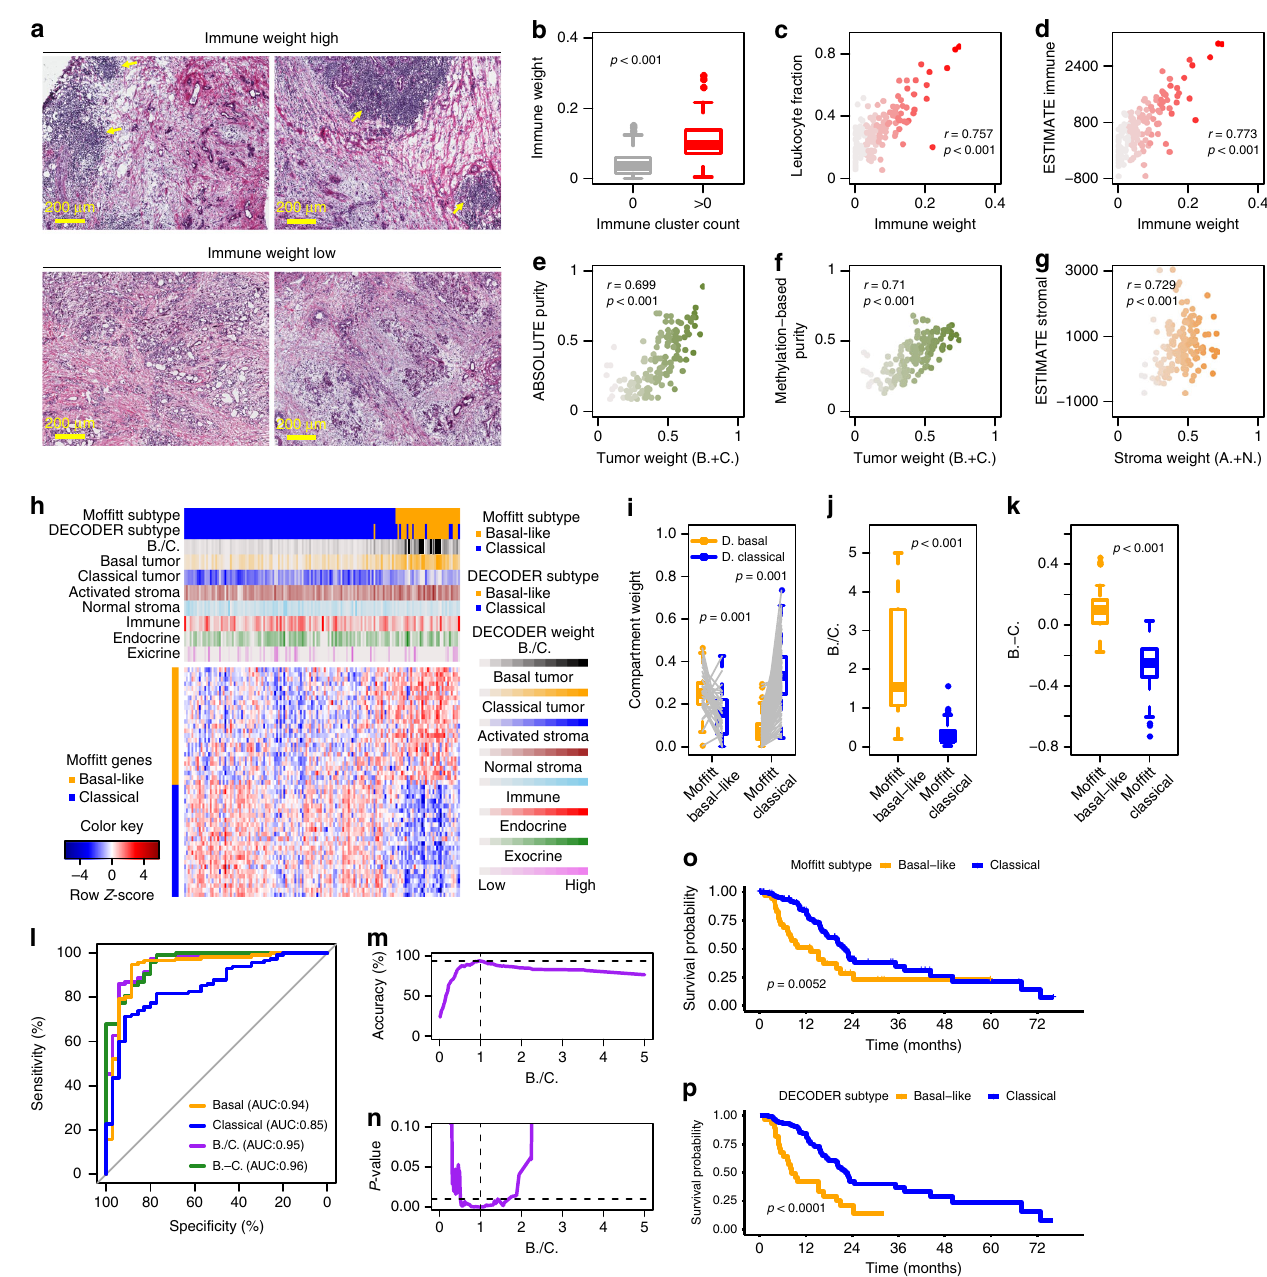
Fig. 2 Deconvolved compartment weights for samples in TCGA PAAD data set. a Representative H&E-stained PDAC tumor sections showing immune cell in fi ltration (arrows) in samples with high immune vs low immune weight samples separated by the median. b Quanti fi cation of immune clusters by H&E staining was correlated with immune weight (two-sided Wilcoxon rank-sum test). c , d Correlations of immune weight with the leukocyte fraction (Pearson correlation) and ESTIMATE immune score (Spearman correlation). e , f Correlations of the sum of basal tumor and classical tumor weights, with tumor purity estimated by ABSOLUTE and methylation (Pearson correlation). g Correlation of the sum of activated stroma and normal stroma weights with ESTIMATE stromal score (Spearman correlation). h Associations of compartment weights with the tumor subtype calls. Heatmap shows consensus clustering of TCGA samples using 50 Mof fi tt tumor exemplar genes. Colored tracks show compartment weights, the ratio between basal tumor and classical tumor weights (B./C.), tumor subtypes called by B./C. (DECODER subtype), and tumor subtypes called by the clustering-based Mof fi tt schema (Mof fi tt subtype). i Basal tumor and classical tumor weights are compared in Mof fi tt Basal-like and Classical samples (paired two-sided Wilcoxon rank- sum test). j , k The ratio (B./C.) and difference (B.-C.) between basal tumor and classical tumor weights are compared in Mof fi tt Basal-like and Classical samples (two-sided Wilcoxon rank-sum test). l The receiver-operating curve (ROC) for basal tumor weight, classical tumor weight, B./C. and B.-C. in classifying subtypes. The area under the ROC (AUC) is shown for each parameter. m Threshold determination for B./C. to classify subtypes based on accuracy using Mof fi tt tumor subtype calls as gold standard. n Threshold determination for B./C. to classify subtypes based on signi fi cance to differentiate survival. o , p Kaplan – Meier plots of overall survival in patients with resected PDAC for Mof fi tt and DECODER tumor subtypes. Patients with B./C. > = 1 were categorized as Basal-like, while those with B./C. < 1 as Classical (log-rank test). Box plots in b , i – k show the median (center line) and interquartile range (box), with whiskers denoting 1.5 times the interquartile range above and below the upper and lower quartile,